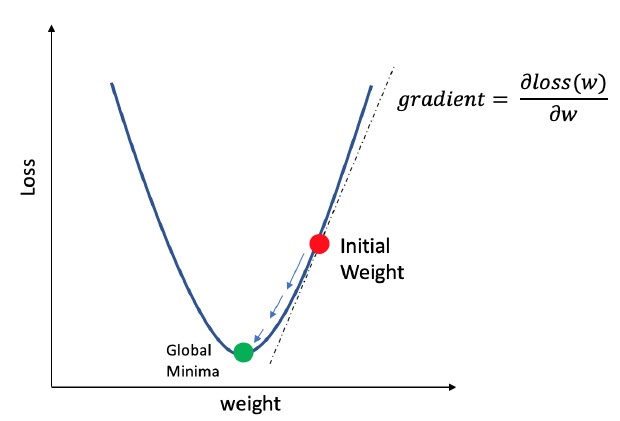
Figure 2. An initial weight value iteratively minimized based on the partial derivative of a loss function to achieve global minima in loss.